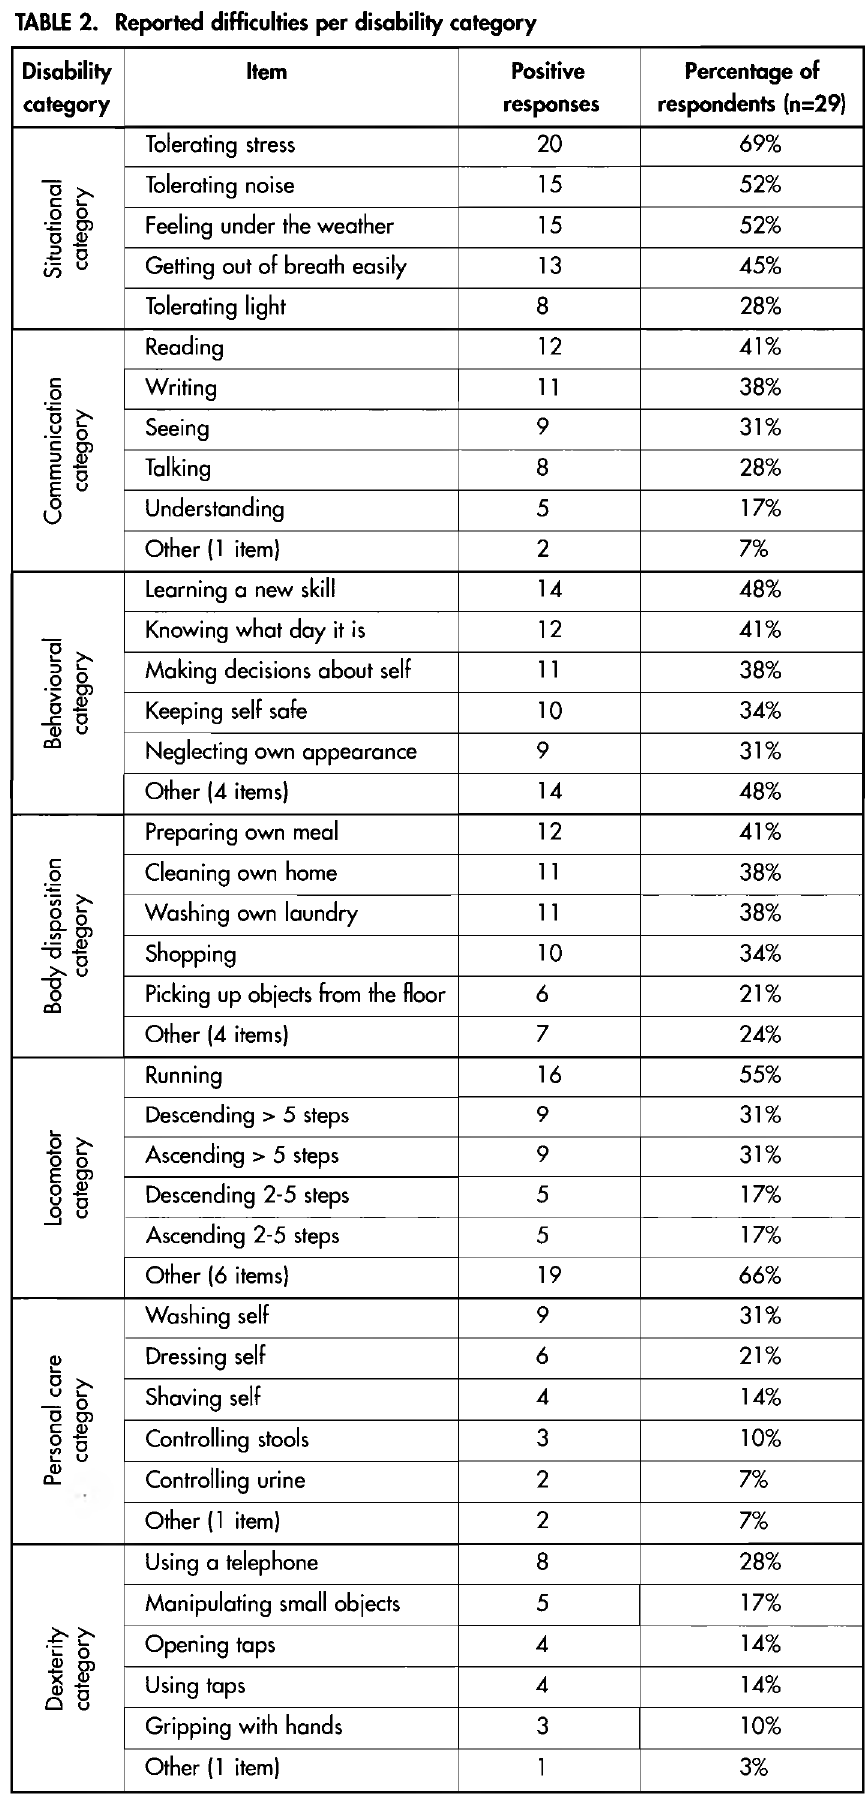
TABLE 2. Reported difficulties per disability